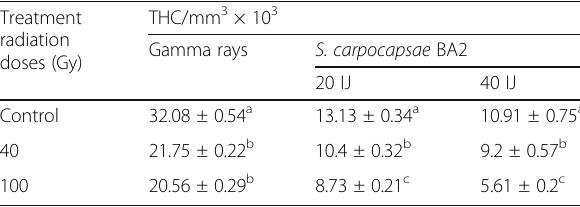
Table 1 Total hemocyte count/mm 3 of blood from Galleria mellonella larvae treated with gamma radiation alone or combined with the entomopathogenic nematode, Steinernema